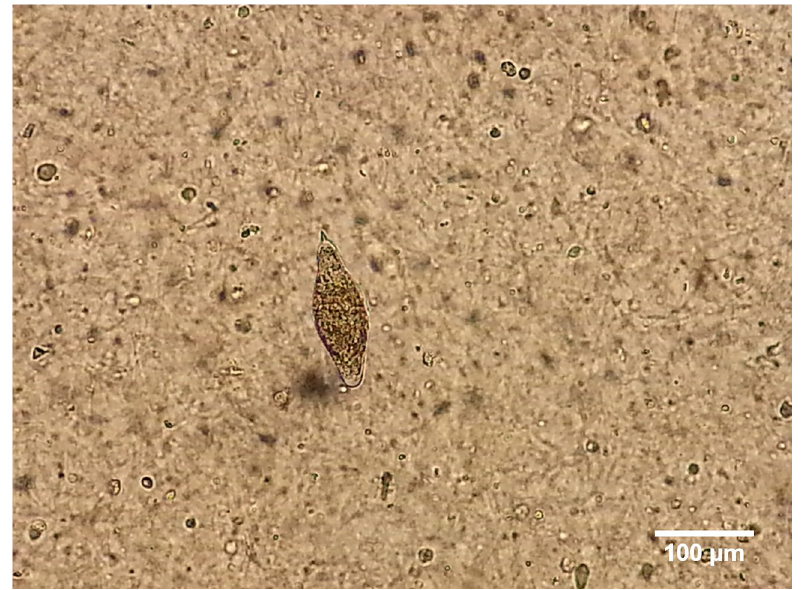
Fig 1. Morphology of the schistosome egg detected in a urine sample from the case report. Scale bar 100 μ